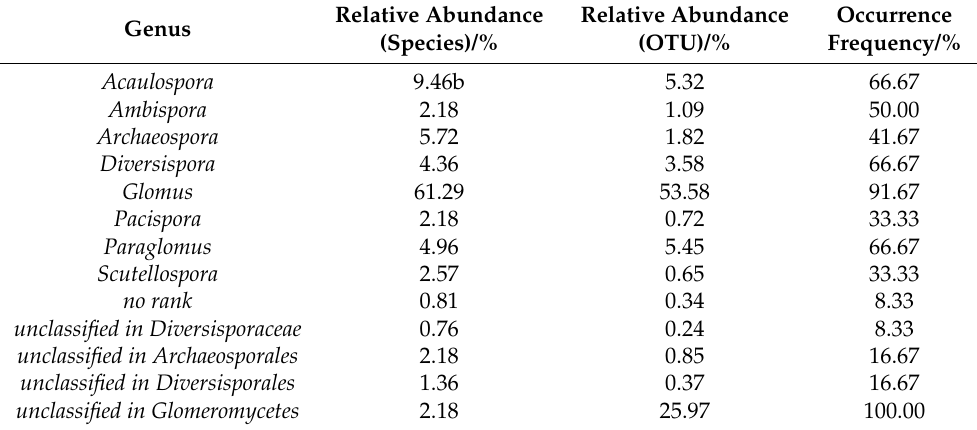
Table 1. Relative abundance and occurrence frequency of AMF genus in Mt. Taibai.